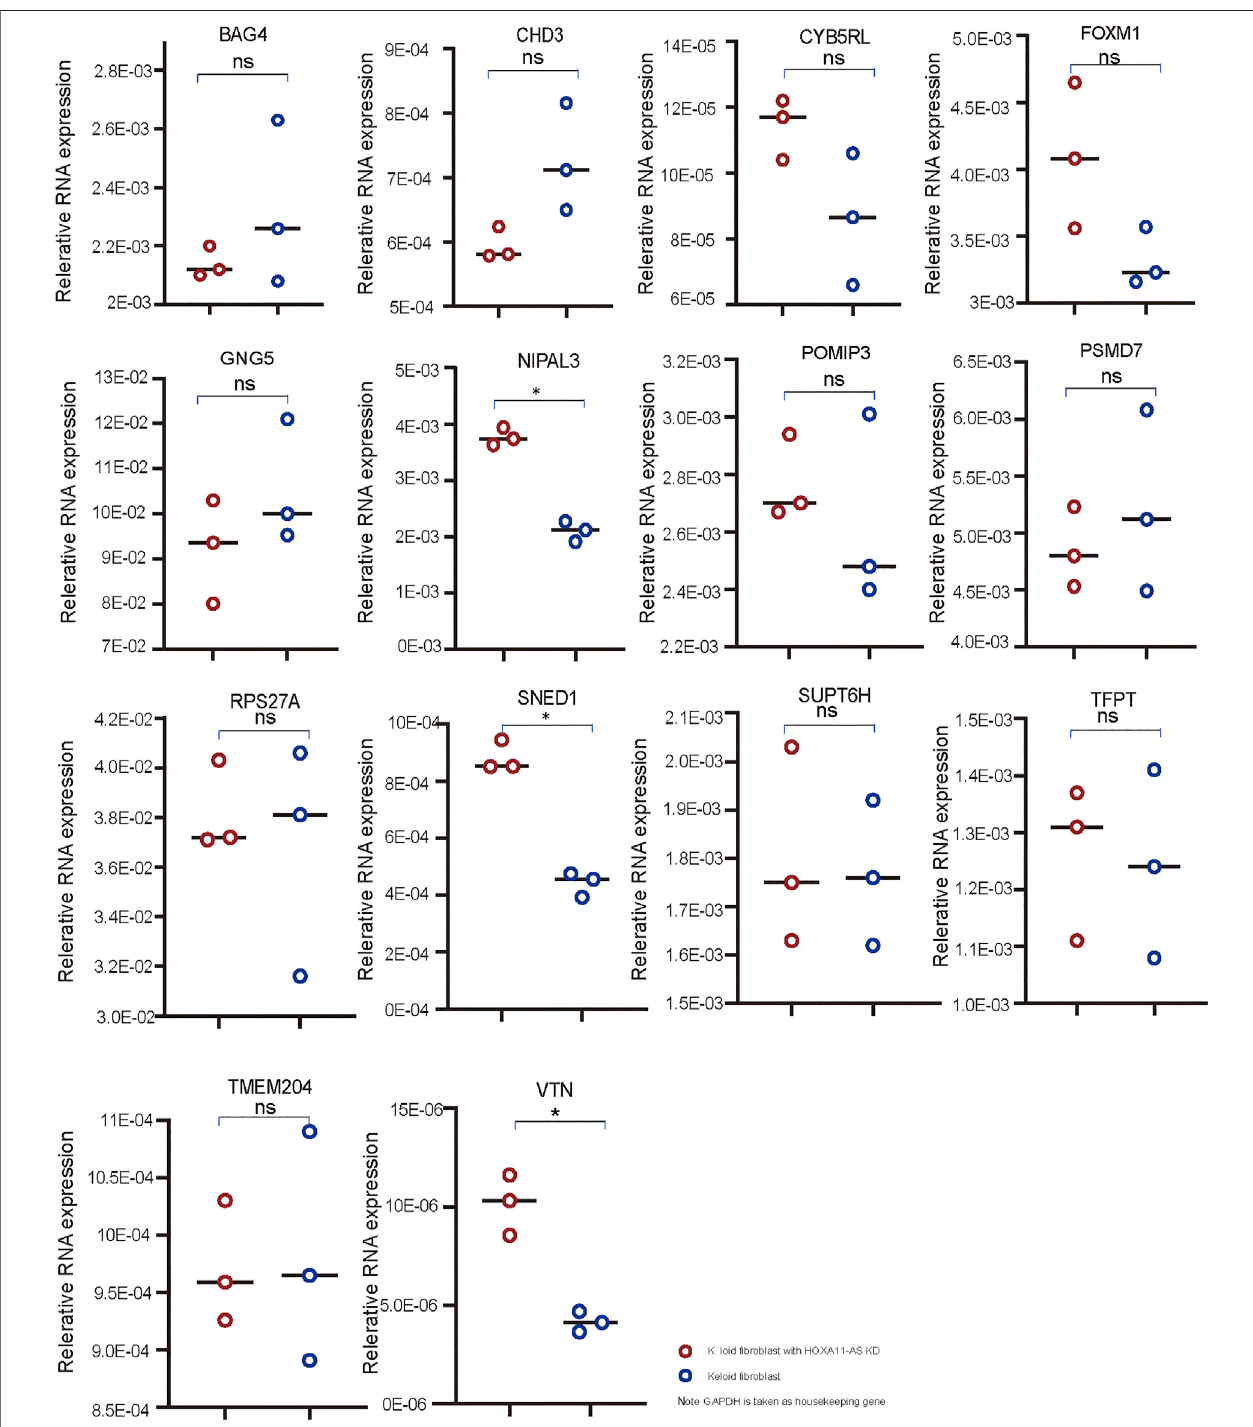
FIGURE 4 | qPCR validation in keloid fi broblasts with HOXA11-AS knockdown Three mRNAs, VTN, SNED1, and NIPAL3, were found to have signi fi cantly altered expression in keloid fi broblasts with HOXA11-AS knockdown based on qPCR validation (* p < 0.05: ns, non signi fi cant).